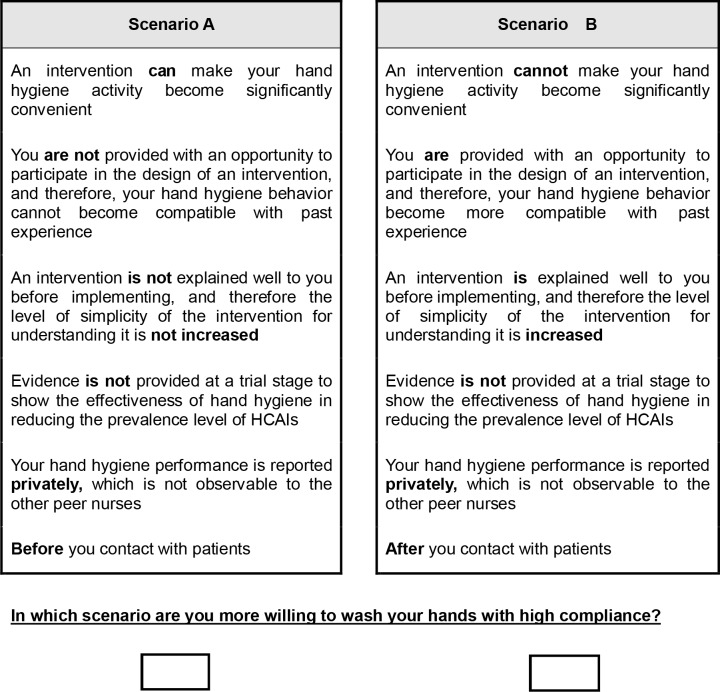
Sample choice set.